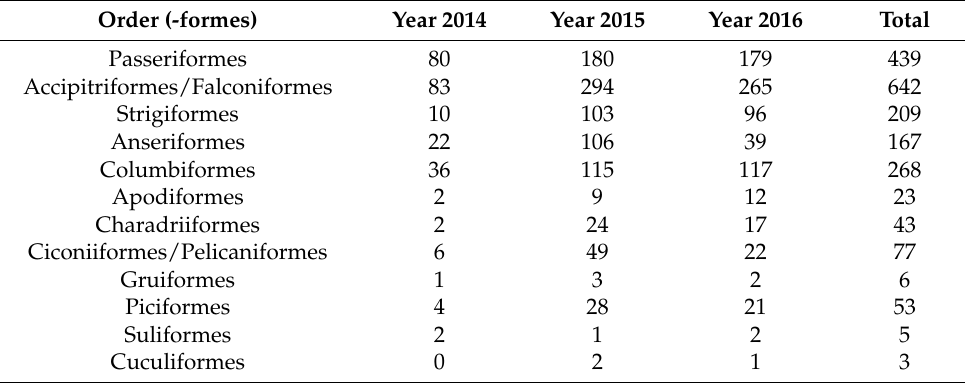
Table 1. Total number of bird orders of which blood samples were taken during the monitoring program from 2014 to 2016 in